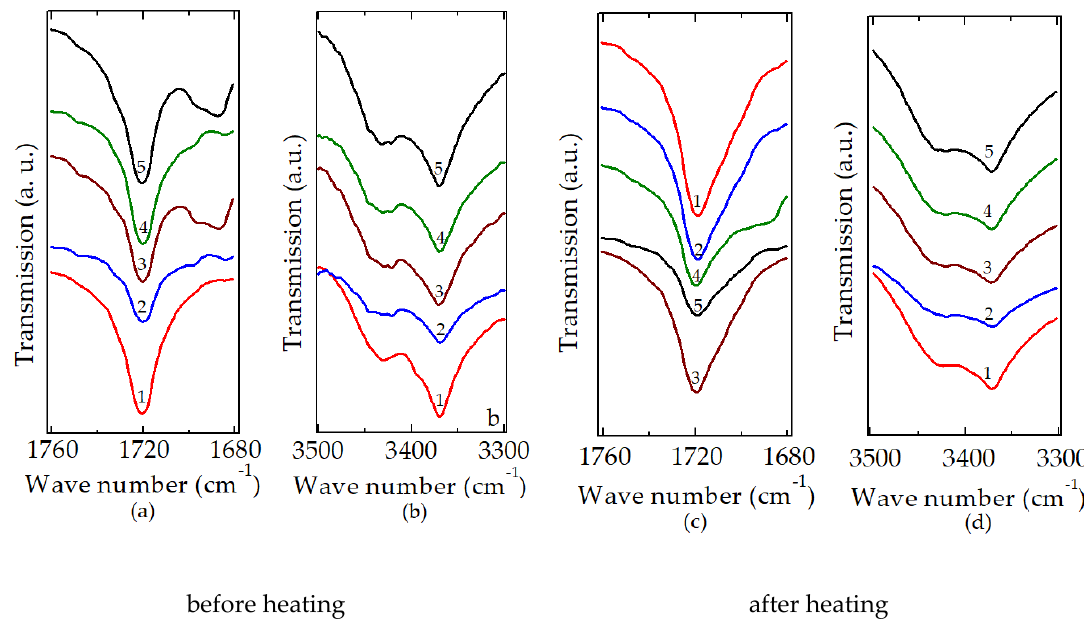
Figure 2. The evolution of carbonyl ( a , c ) and hydroxyl ( b , d ) bands in LDPE / UHMWPE-based formulations. Indices denote the following: (1) LDPE / UHMWPE, (2) LDPE / HAp, (3) LDPE / HAp / RM, (4) LDPE / UHMWPE / HAp, (5) LDPE / UHMWPE / HAp / RM.